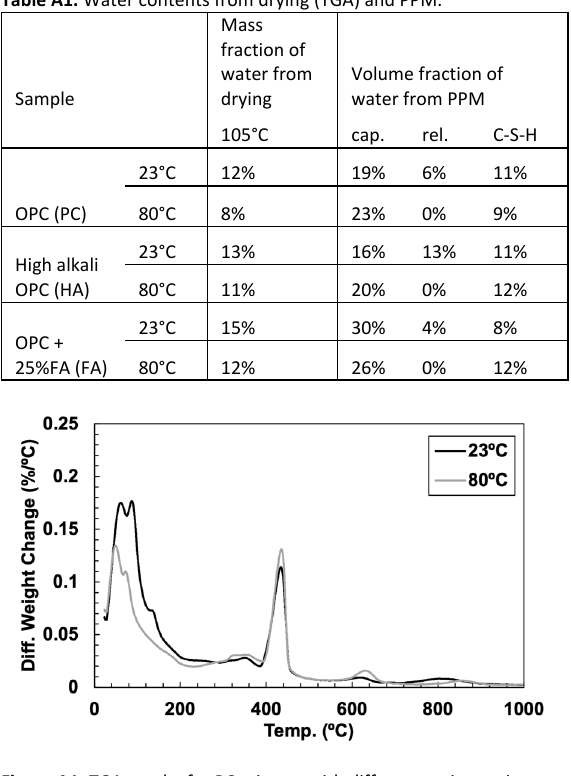
Figure A1. TGA results for PC mixture with different curing